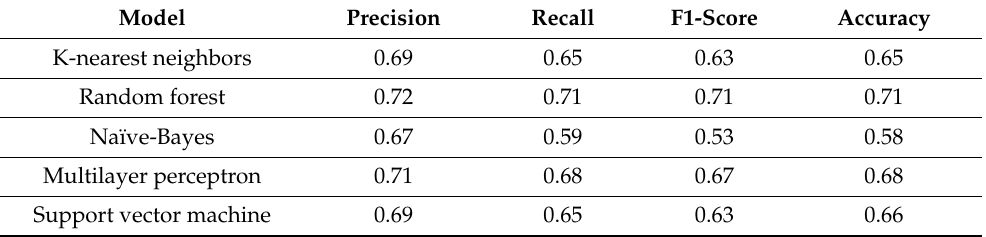
Table 3. Classification of different learning models for feature